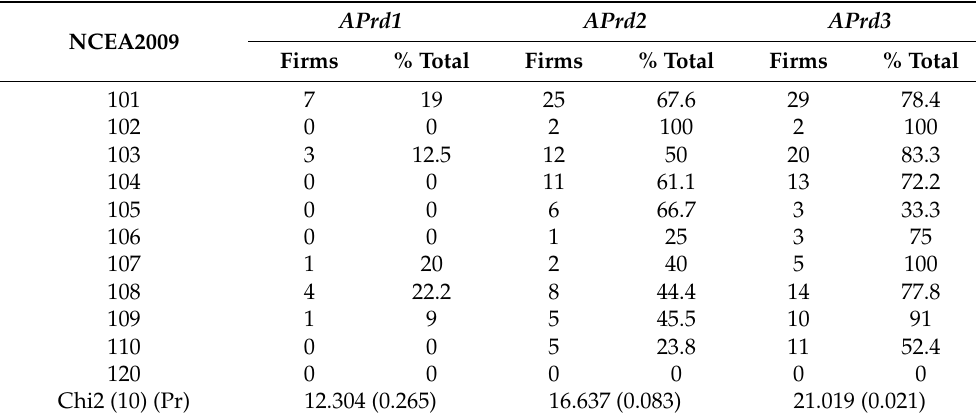
Table 6. Changes carried out in the procedures according to the branch of